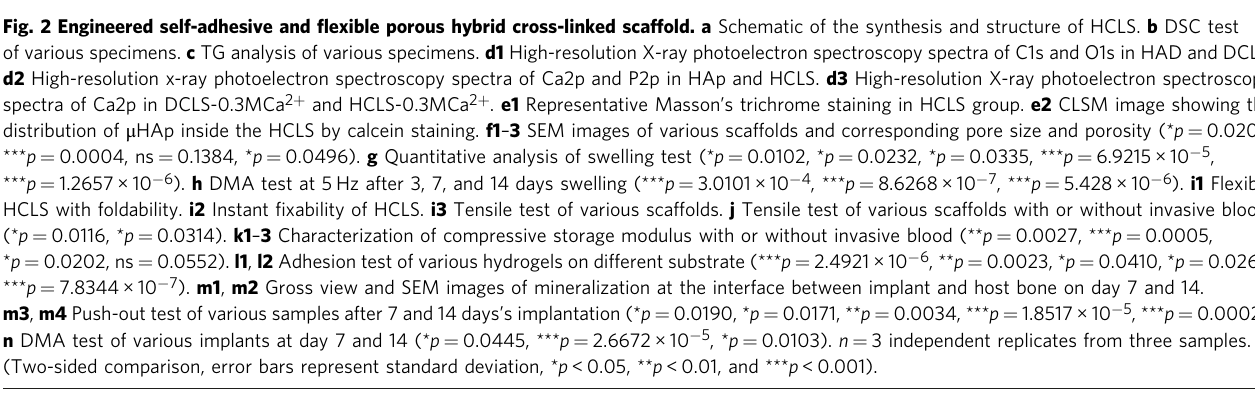
Fig. 2 Engineered self-adhesive and fl exible porous hybrid cross-linked scaffold. a Schematic of the synthesis and structure of HCLS. b DSC test of various specimens. c TG analysis of various specimens. d1 High-resolution X-ray photoelectron spectroscopy spectra of C1s and O1s in HAD and DCLS. d2 High-resolution x-ray photoelectron spectroscopy spectra of Ca2p and P2p in HAp and HCLS. d3 High-resolution X-ray photoelectron spectroscopy spectra of Ca2p in DCLS-0.3MCa 2 + and HCLS-0.3MCa 2 + . e1 Representative Masson ’ s trichrome staining in HCLS group. e2 CLSM image showing